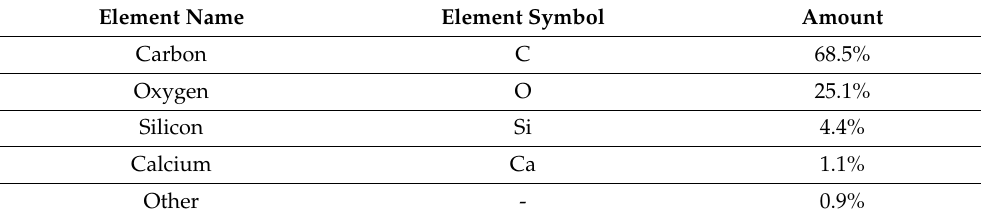
Table 1. Chemical composition of material M1.